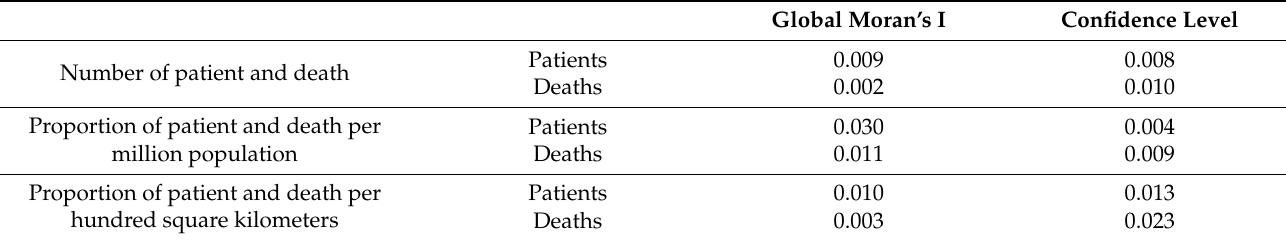
Table 3. The Value of Global Moran’s